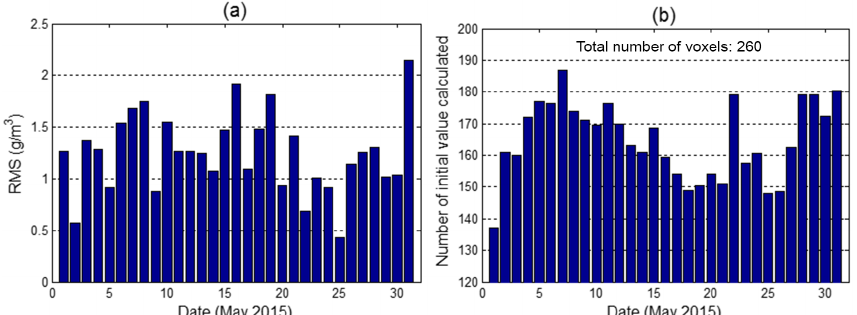
Figure 8. RMS for the water vapor unit index model and the number of initial values calculated using the established model for the 31days from 1 to 31 May 2015.